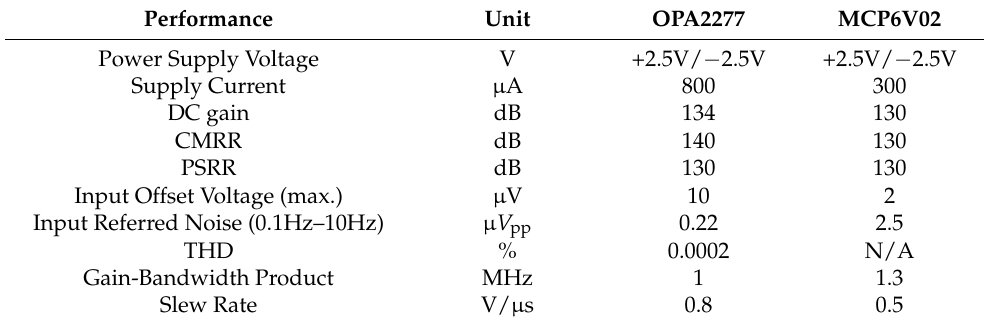
Table 1. Main Electrical Characteristics of the Precision Opamps included in the EMI test